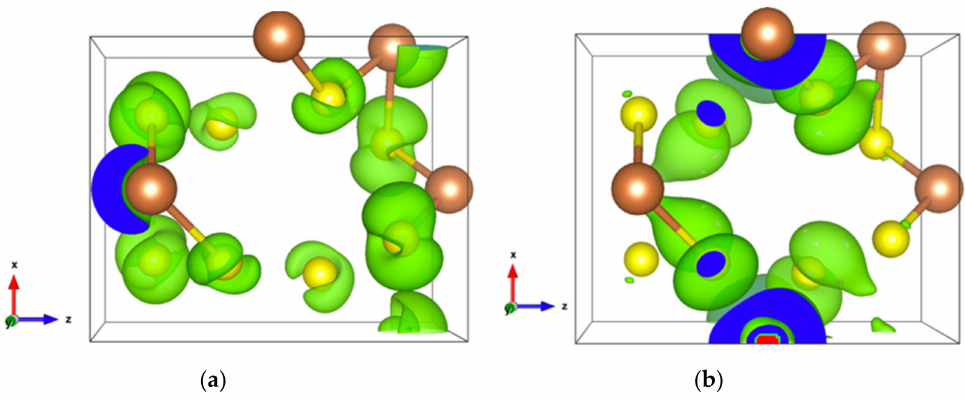
Figure 9. Electronic density of SbS 2 . ( a ) In the energy range comprising the top two valence orbitals with an isosurface of 0.004 electrons / bohr 3 ; ( b ) For the single bottom conduction orbital with an isosurface of 0.003 electrons / bohr 3